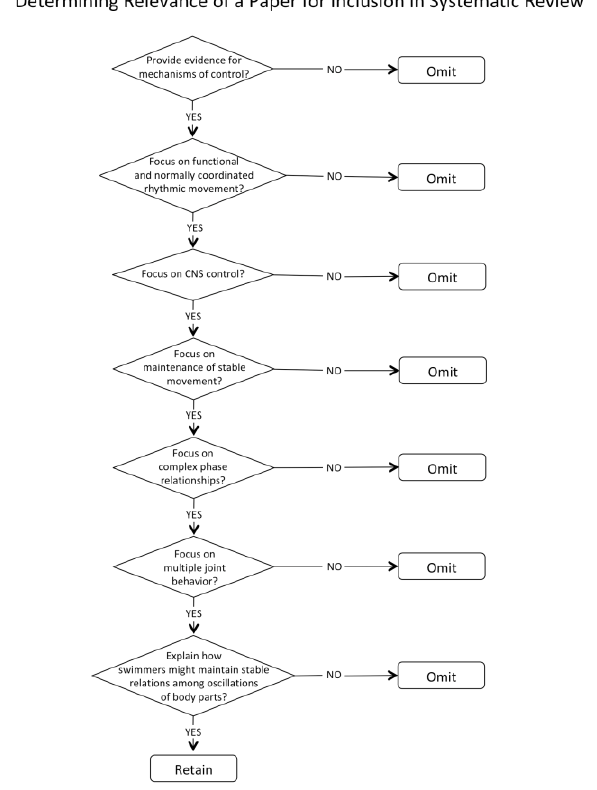
Figure 3. Flowchart for assessing the relevance of papers.